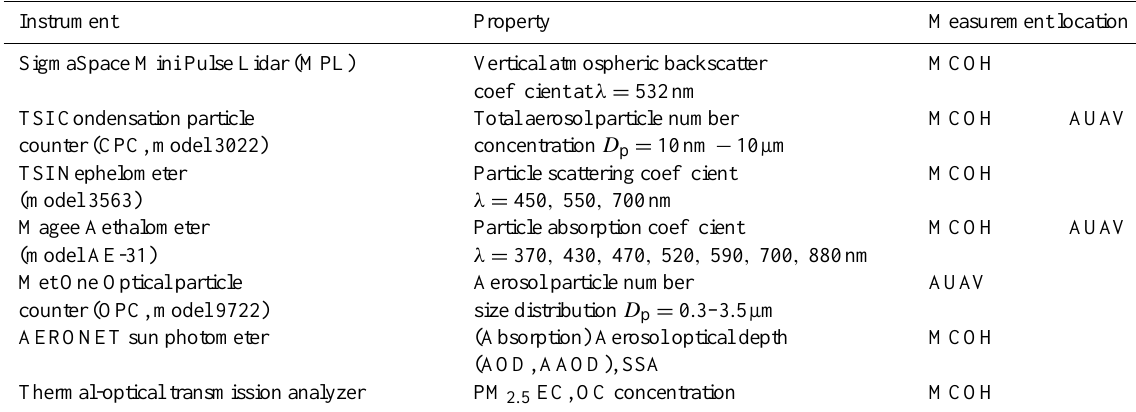
Table 1. Instruments used during CARDEX at MCOH and onboard the AUAV.